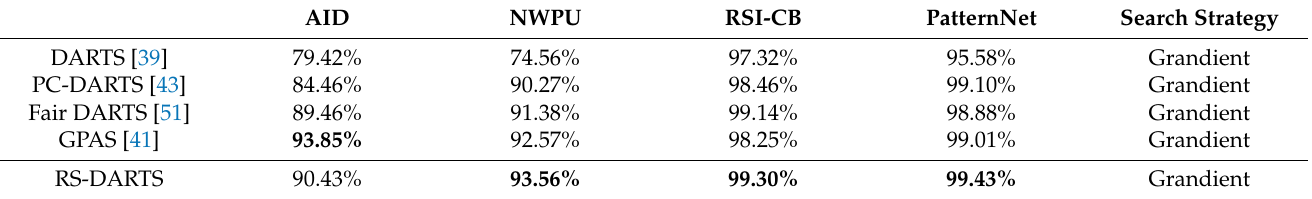
Table 7. Comparison results of the classification accuracy of the final CNN model searched by RS-DARTS and other NAS methods. When trained this searched model, we sampled 40% images as training set (These boldface numbers indicate the highest accuracy).